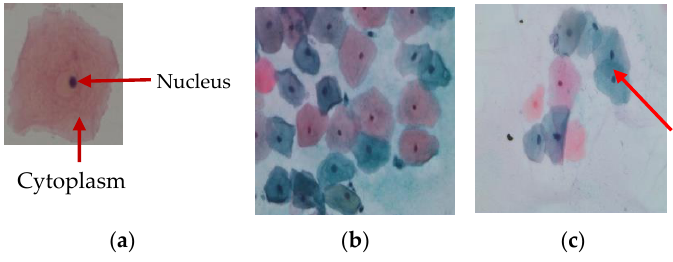
Figure 1. ( a ) Single-cell image (nucleus and cytoplasm), ( b ) Multi-cells image, and ( c ) Overlapping cytoplasm.